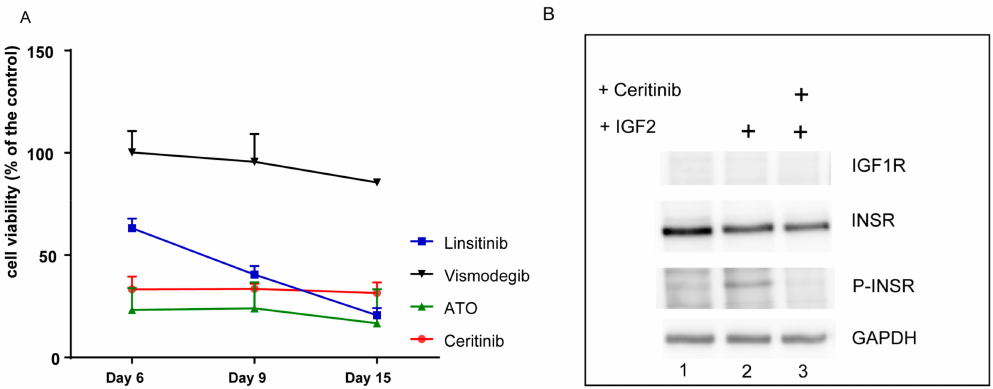
Figure 5. The primary tumor cells are sensitive to arsenic trioxide (ATO) and ceritinib. ( A ) 225ZL cells were grown for 15 days in the presence of ATO, vismodegib, linsitinib, or ceritinib. As control, the vehicle alone was used. The percentage of the growth compared to the control is shown. The proliferation experiments were carried out in biological duplicates. Data are represented as the mean ± standard deviation (SD). ( B ) 225ZL cells were stimulated after starvation with IGF2 in the presence or absence of 1 µ M of ceritinib. The expression of IGF1R, insulin receptor (INSR), and the phosphorylated form of INSR (P-INSR) was analyzed by Western blot with specific antibodies. Glyceraldehyde-3-phosphate dehydrogenase (GAPDH) was used as loading control. A representative experiment of two independent experiments is